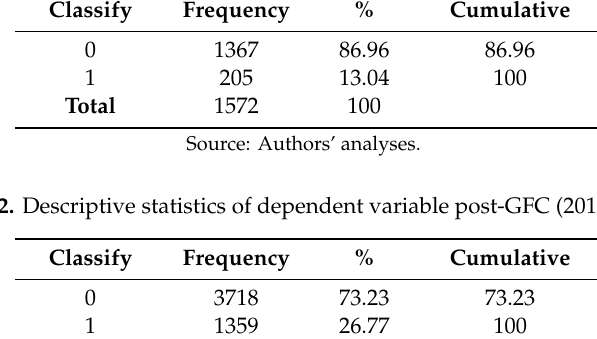
Table 1. Descriptive statistics of dependent variable during GFC (2007–2009). Classify Frequency %